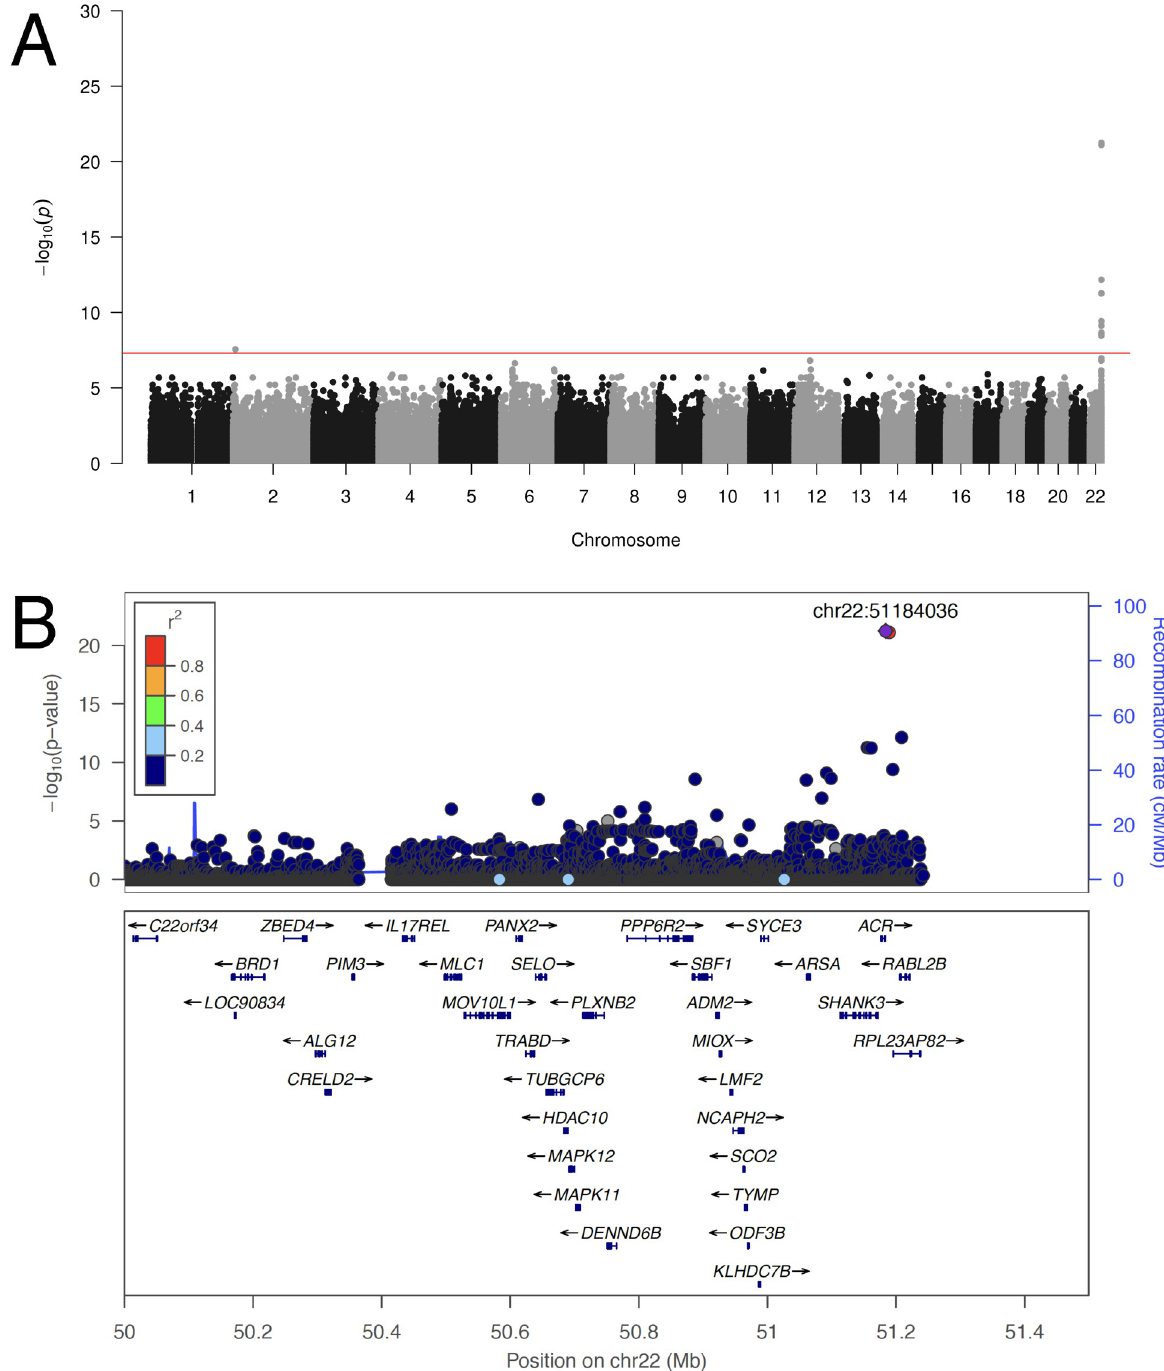
Fig 5. A prevalent endogenous HHV-6B variant integrated into chr22q. A) Manhattan plot presenting the P values for association between variants and clonal integrated HHV-6B (N = 20). The − log10 P value (Fisher’s exact test) given for each variant is plotted according to the variant’s physical position on the chromosome. B) Regional association plot of the 22q region. The − log10 P value (Fisher’s exact test) for association in the GWAS of integrated HHV-6A are shown. The purple diamond symbol represents the lead variant in the region of the association. Proxies are indicated with colors determined from their pairwise r 2 from the high-depth BBJ WGS data (red, r 2 > 0.8; orange, r 2 = 0.6 − 0.8; green, r 2 = 0.4 − 0.6; blue, r 2 = 0.2 − 0.4; dark blue, r 2 < 0.2 or no information available).